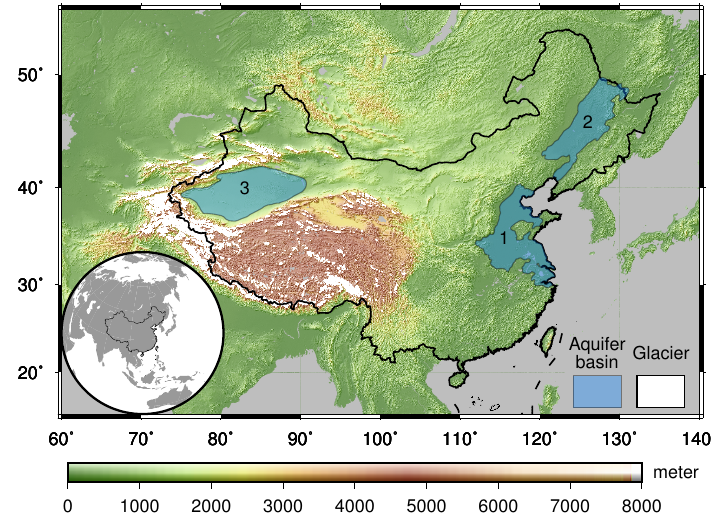
Figure 1. Map of China showing three main aquifer basins (i.e., (1) North China Aquifer System; (2) Song-Liao Basin; and (3) Tarim Basin). The boundaries of the three aquifers are based on the delineation of the world’s 37 large aquifer systems from the World-wide Hydrogeological Mapping and Assessment Programme (WHYMAP) [47]. The white areas denote glaciers from the Randolph Glacier Inventory (RGI 6.0)